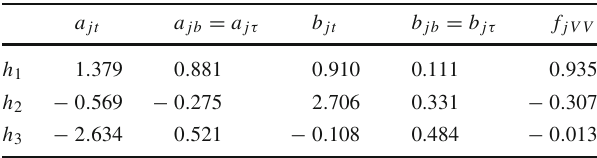
Table 1 Benchmark values of the reduced couplings of the neutral Higgs bosons h j to quarks, leptons, and weak gauge bosons with jVV to the weak gauge bosons are given in units of m